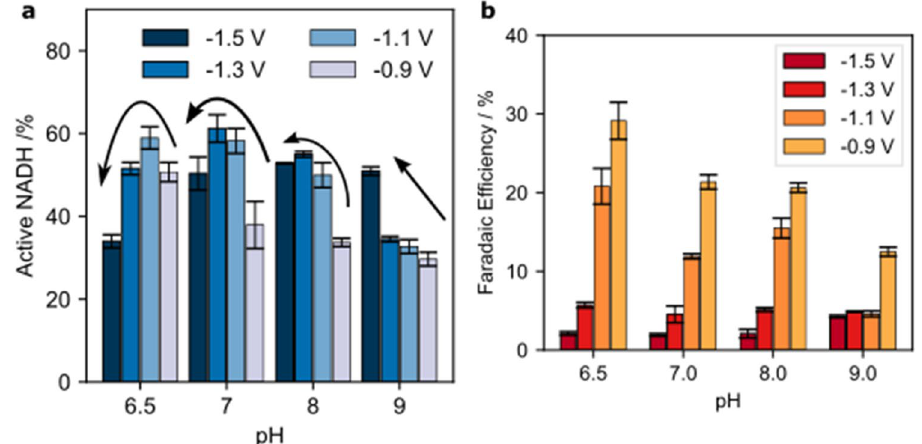
Figure 4. Influence of pH and electrode potential on the NADH regeneration. ( a ) Percentage of active 1,4- NADH produced with a copper electrode at potential (− 0.9 to − 1.5 V) vs. Ag|AgCl|KCl 3M and using 1.5 mM NAD + in Tris buffer for 1800s. ( b ) Faradaic efficiency of the NADH regeneration.